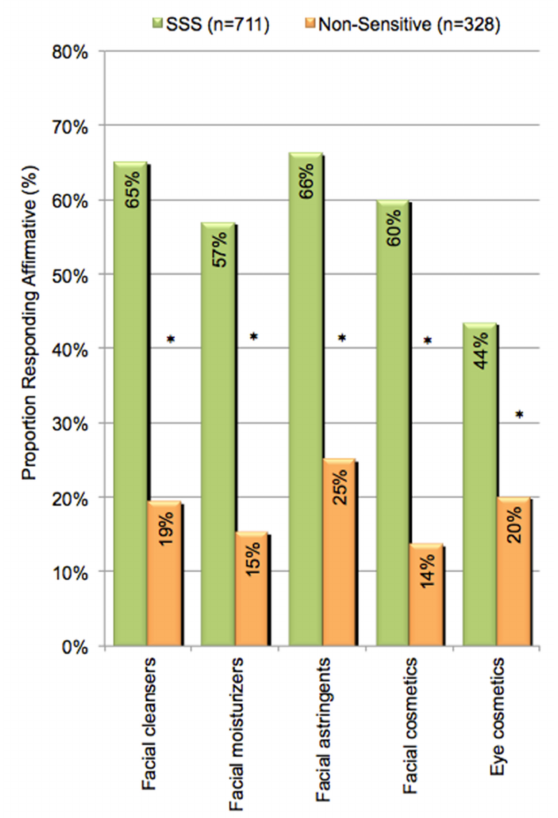
Figure 3. Facial product triggers for SSS symptoms. In the Cincinnati study, responders were asked if certain environmental factors triggered SSS symptoms [7,80]. For all factors the proportion of SSS individuals who responded positively was significantly higher than the number of non-sensitive individuals who responded positively. (* = p <